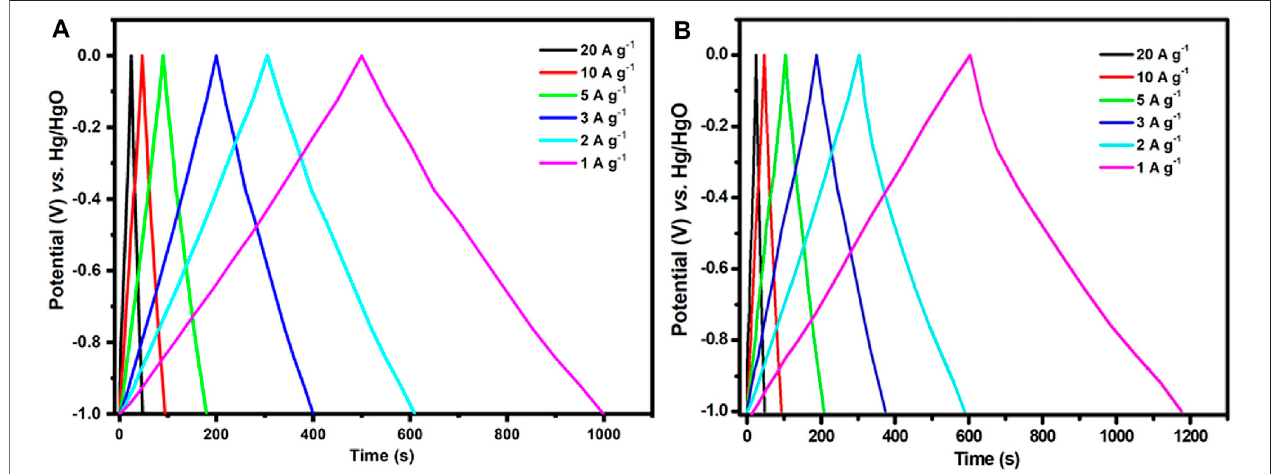
FIGURE 12 | GCD curves of (A) c-2CzPN – KOH and (B) c-4CzPN – KOH tested at various current densities.